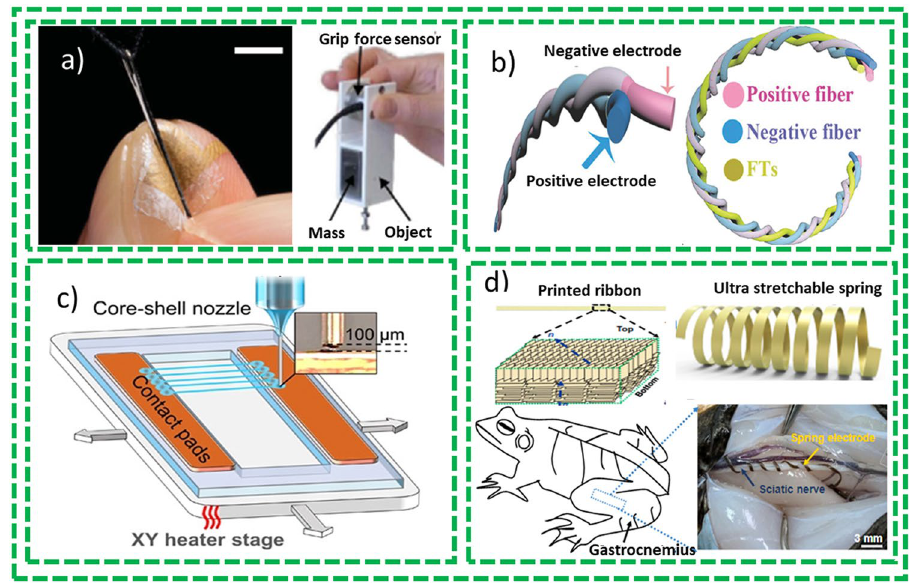
Fig. 17 Fiber-based wearable sensing devices. a Nanomesh flexible pressure sensor for observing fingers control without sensory intervention reprinted with permission from Ref. [197]. b CNT fiber-based temperature sensors Reprinted with permission from Ref. [199]. c Inflight fiber- based 3D printed chemical sensors Reprinted with permission from Ref. [200]. d GO/SA micro-ribbon comprises of direct ink-based nanoflake- based ionic neural electrodes Reprinted with permission from Ref.